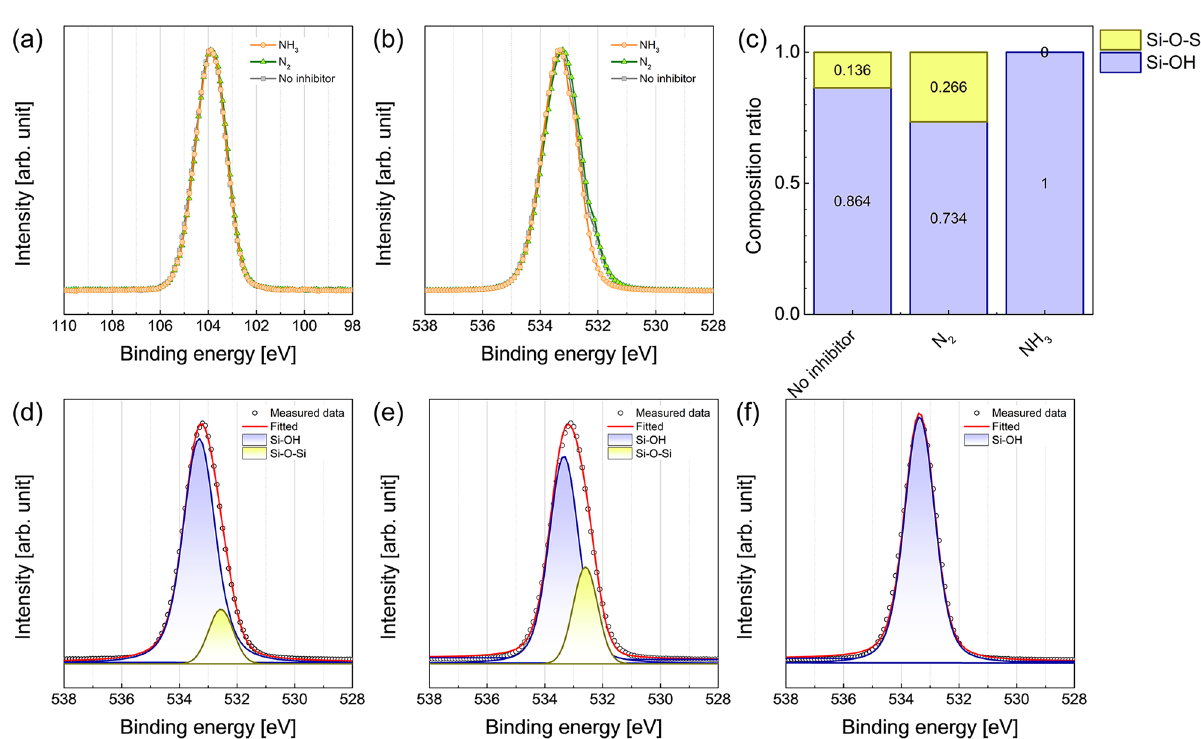
Figure 3. XPS profiles of ( a ) Si2 p , and ( b ) O1 s of SiO 2 thin films. ( c ) Composition ratio of Si–O–Si and Si–OH bonding in O1 s XPS spectra. Deconvoluted XPS O1 s peaks of SiO 2 thin films with ( d ) no inhibitor, ( e ) N 2* , and ( f ) NH 3*